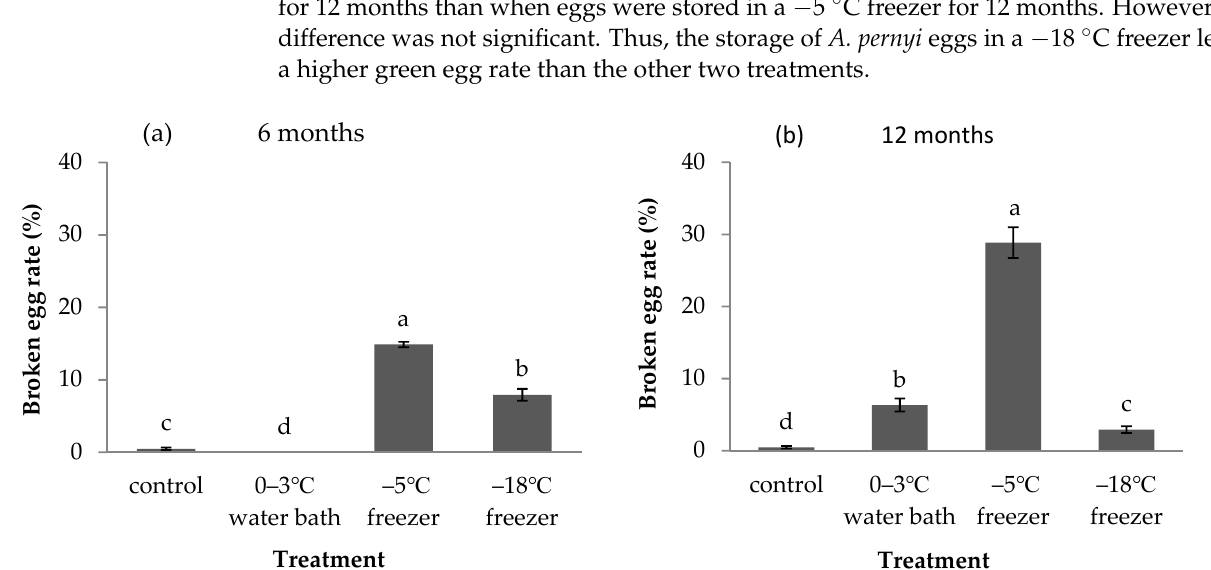
Figure 1. Rate of broken A. pernyi eggs that were stored at a low temperature for 6 months ( a ) and 12 months ( b ) (mean ± SE%). Control represents fresh eggs. Bars sharing the same letters are not significantly different (one-way ANOVA, followed by LSD multiple comparison tests, p < 0.05) between different treatments.